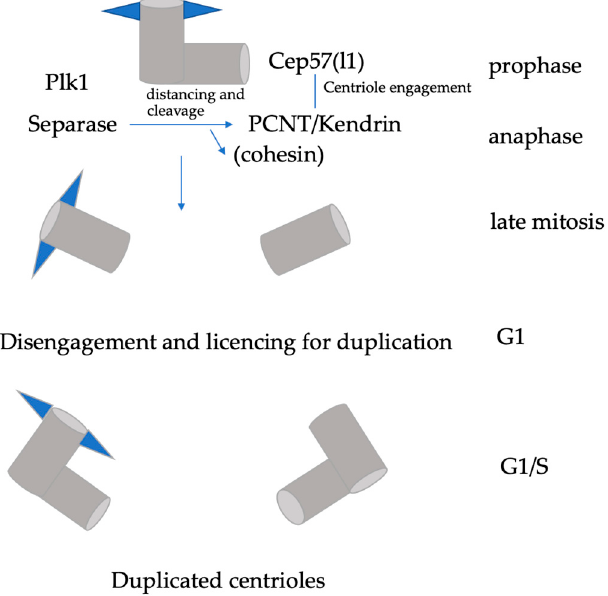
Figure 1. Regulation of centriole disengagement. Maintenance of centriole engagement in mitosis is dependent on the interaction between Cep57 and PCNT/kendrin, and in part by cohesin. Plk1 activity promotes distancing of centrioles. Cleavage of PCNT by separase induces centriole disengagement and licencing for centriole duplication.